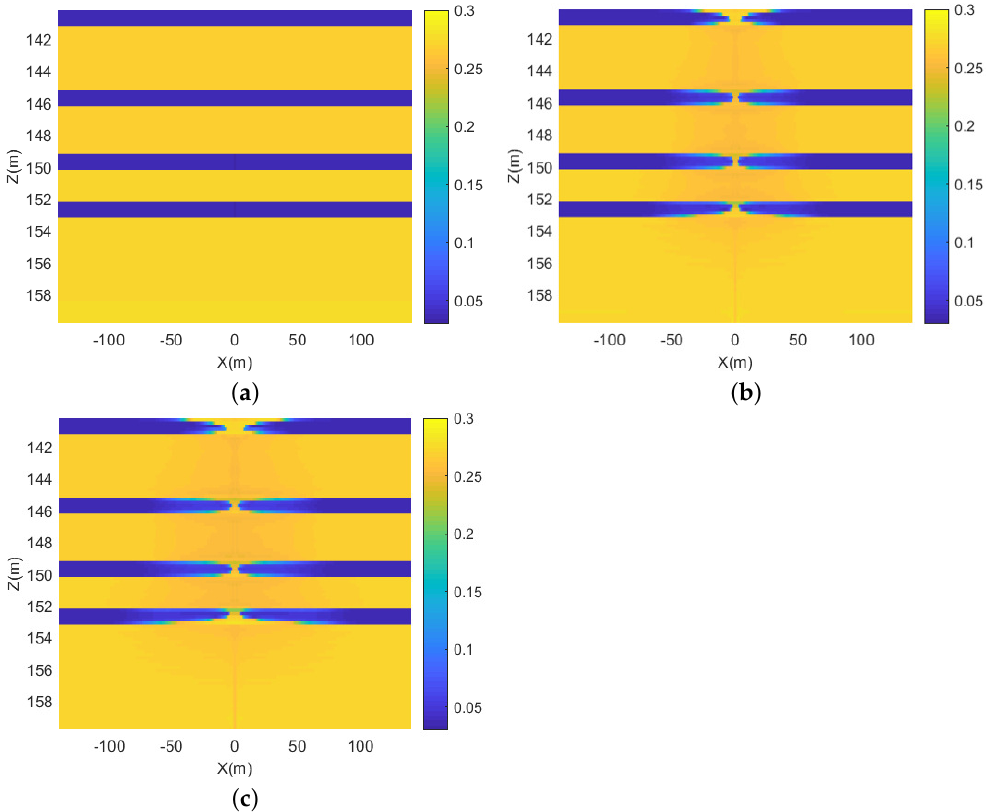
Figure 11. Electrical conductivity models (unit: S/m): ( a ) after day 0 (the initial state), ( b ) after 100 days, and ( c ) after 154